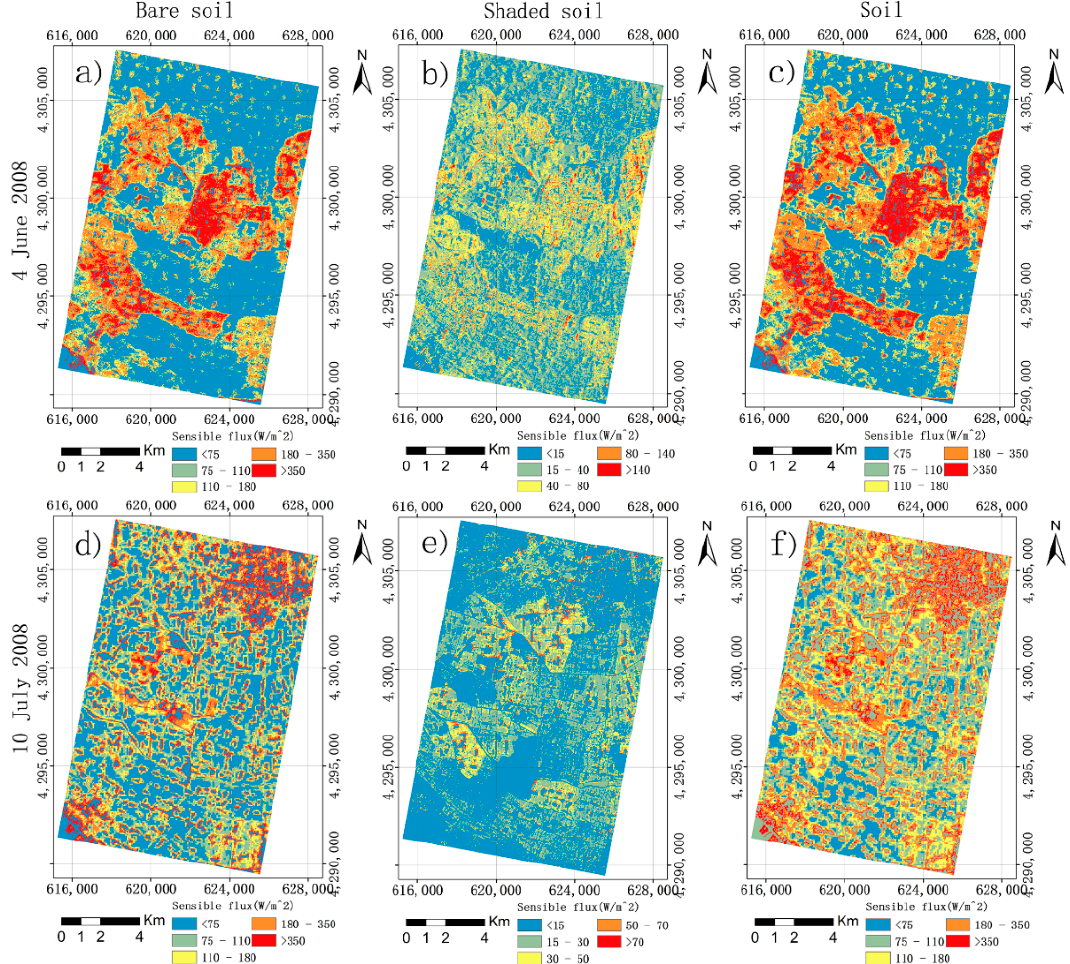
Figure 9. Spatial distributions of the bare soil, shaded soil, and total soil sensible fluxes for the study area: ( a , d ) bare soil; ( b , e ) shaded soil; and ( c , f ) total soil sensible flux using the June 4th image and July 10th image of 2008, respectively.